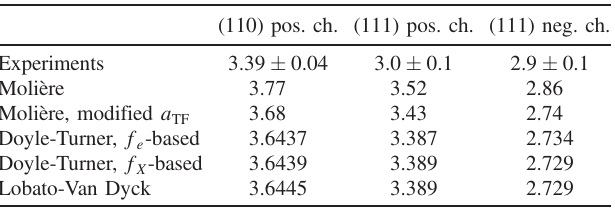
ffiffiffiffiffiffiffiffiffiffiffiffiffiffiffiffiffiffiffiffiffiffiffiffiffiffiffi TABLE I. Mean values of h comparison with predictions based on model potentials. Moli`ere potential corresponds to the screening radius evaluated by Eq. (81). Moli`ere with modified a is evaluated via Eq. (84). TF